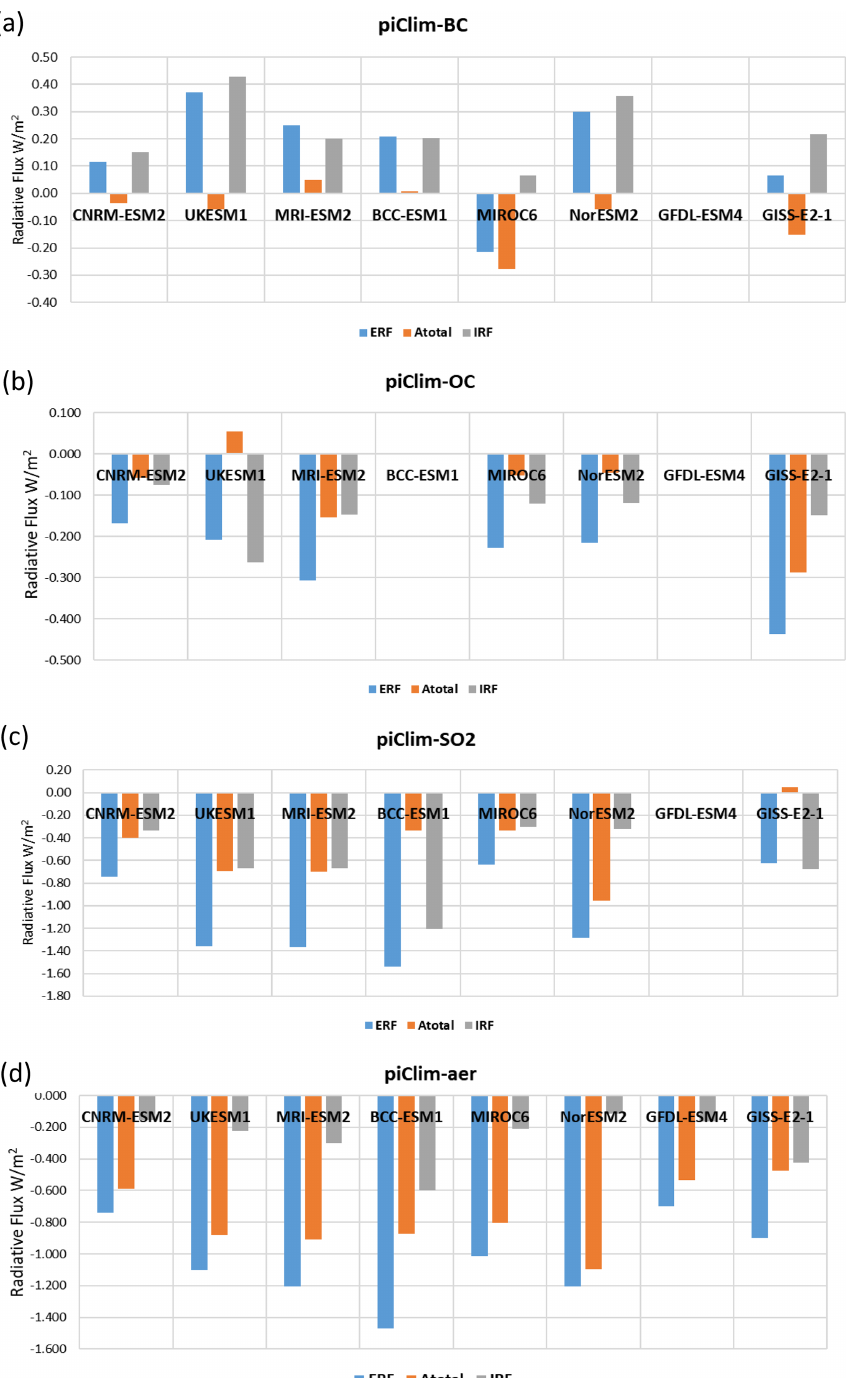
Figure 2. Breakdown of the ERFs into the atmospheric rapid adjustments (Atotal) and IRF (instantaneous radiative forcing) for the aerosols. (a) piClim-BC experiment; (b) piClim-SO 2 experiment; (c) piClim-OC experiment; (d) piClim-aer experiment.